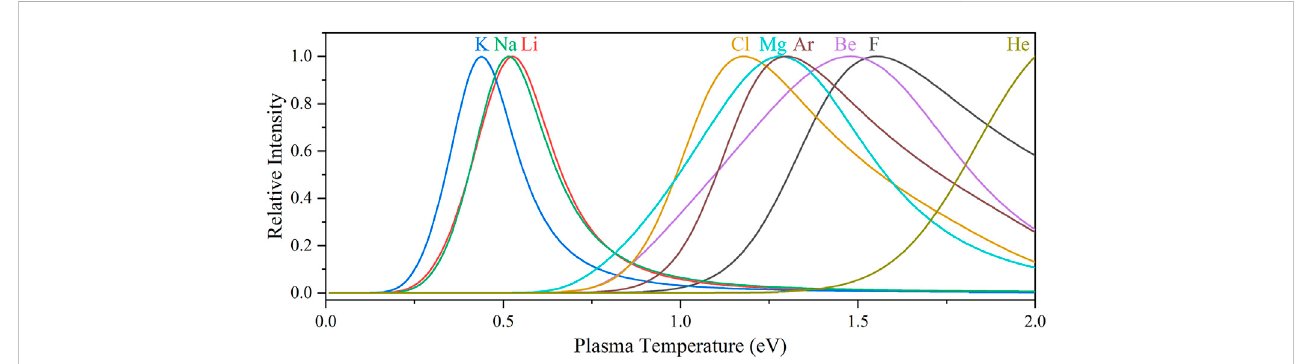
FIGURE 4 Fluoride- and chloride-salt species ’ and carrier gas candidates ’ LIBS emission intensities versus plasma temperature (constant electron density = 10 17 cm − 3 ). The most intense emission peaks were selected for this comparison: F I 685.6 nm, Li I 670.7 nm, K I 766.7 nm, Na I 589.2 nm, Be II 313.2 nm, Cl I 837.8 nm, Mg II 279.6 nm, Ar I 811.8 nm, and He I 587.7 nm. The spectral intensities have been normalized (0 – 1) to their maximum intensity for comparison